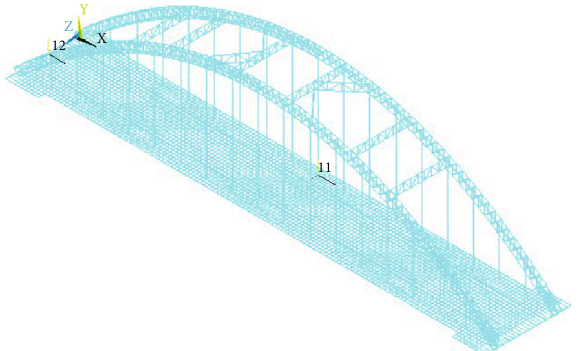
Figure 1: The fi nite element calculation model of CFST arch